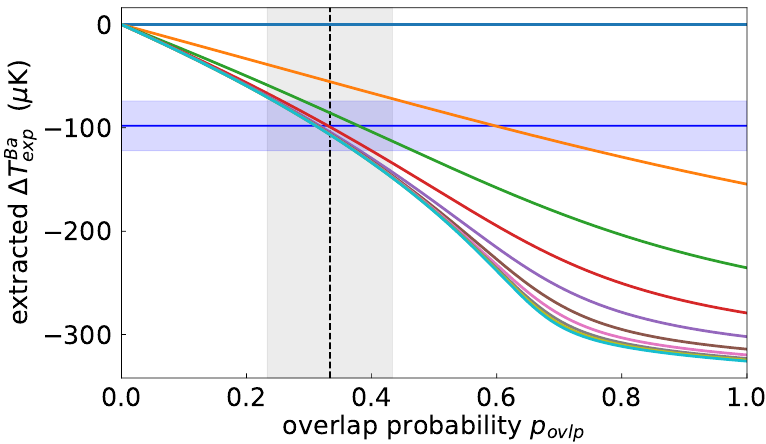
Figure 6. Expected changes of ion kinetic energies ∆ T Ba exp after N Lgvn = 0 (top cruve) to N Lgvn = 9 (bottom curve) Langevin collision(s) for different assumed probabilities p ovlp to observe full overlap between the ion and the atomic cloud stemming from fluctuations of the ODT alignment. The result from [41] is shown as the blue horizontal line with the shaded area denoting the uncertainties. The experimentally estimated overlap probability and its uncertainty are depicted as the black dashed line and the grey shaded region,